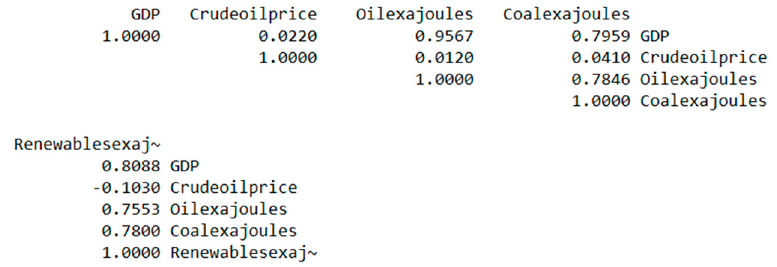
Figure 15. Correlation matrix for the variables.